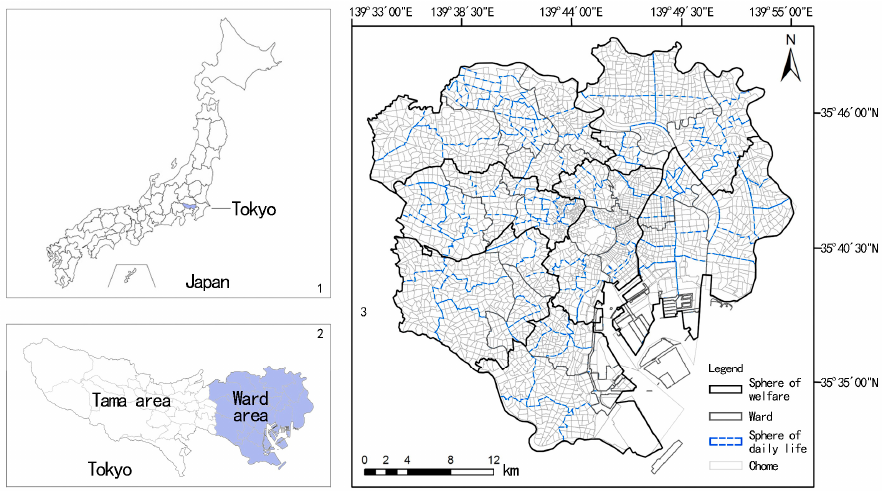
Figure 1. Spatial units within the ward area of Tokyo.